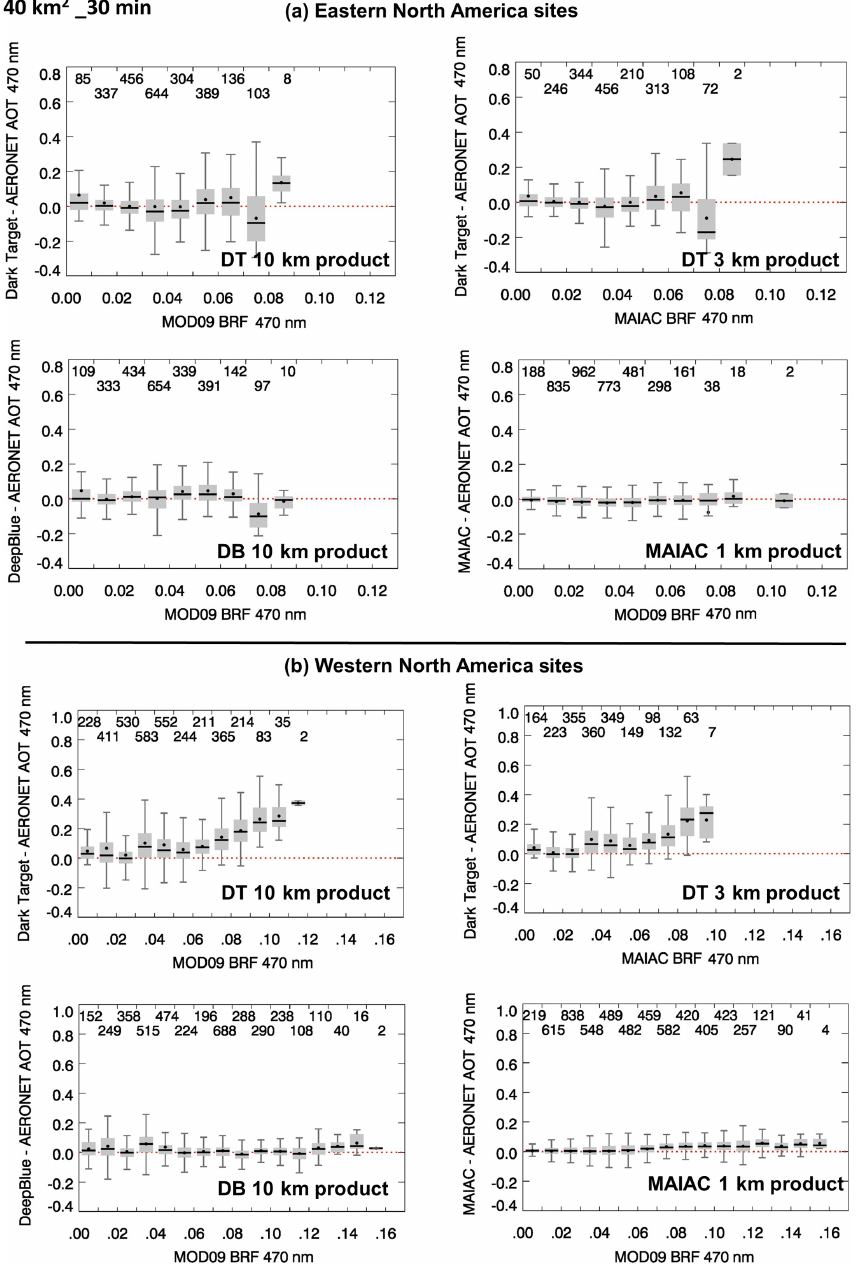
Figure 6. Difference in AOT (470nm) between MODIS and AERONET as a function of coincident bidirectional reflectance retrievals (470nm) from the MODIS MOD09 product for sites in eastern (a) and western (b) North America. Data are represented as a box-and- whisker plot with the thick horizontal line as the median, black dot as mean, shaded boxes covering the 75th and 25th percentiles, and vertical lines as 1.5 times the interquartile range (25–75th percentiles). The number of matchups for each bin is shown at the top of the